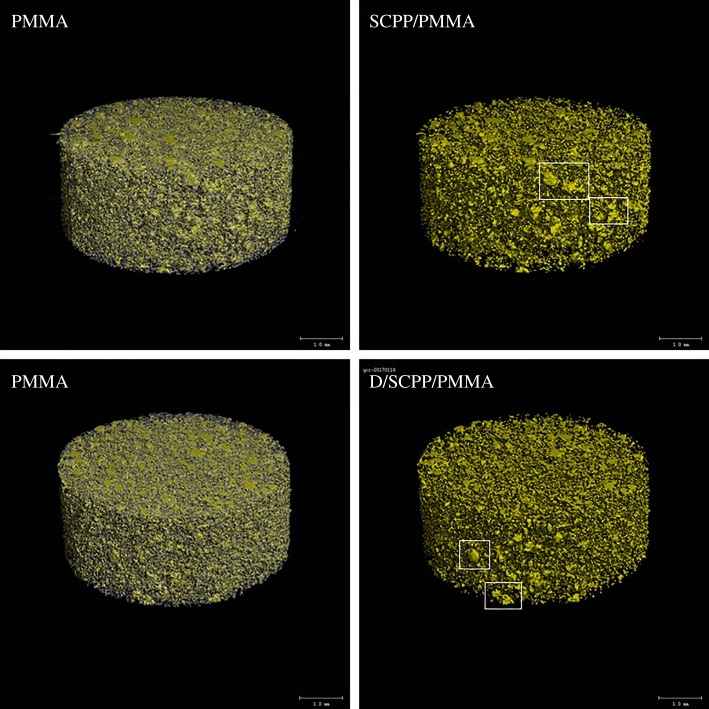
Micro-CT of PMMA bone cement composite (white boxes indicate agglomeration).